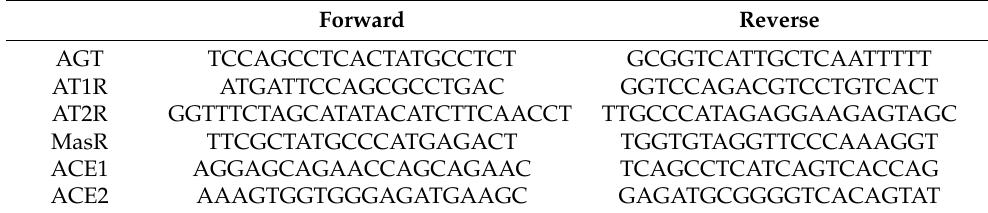
Table 1. Primer sequence used in the digital droplet PCR